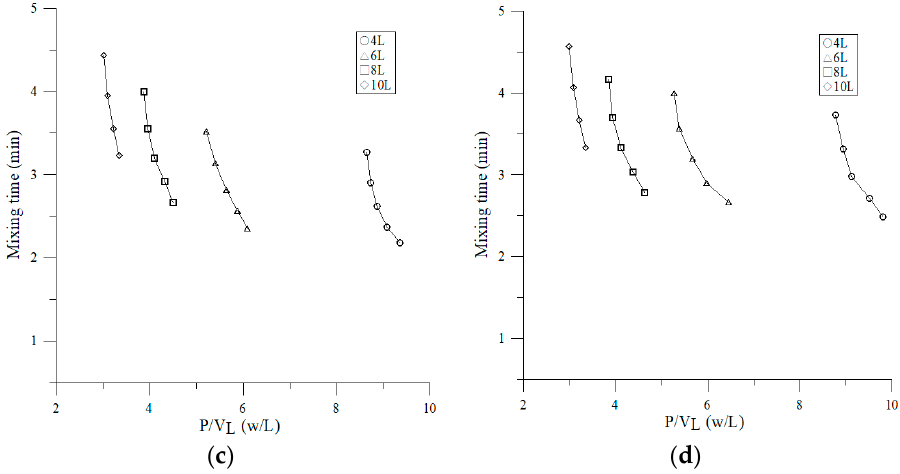
Figure 10. Effect of volumetric power consumption on mixing time. ( a ) Water; ( b ) 5 vol% glycerin; ( c ) 10 vol% glycerin; ( d ) 20 vol% glycerin.